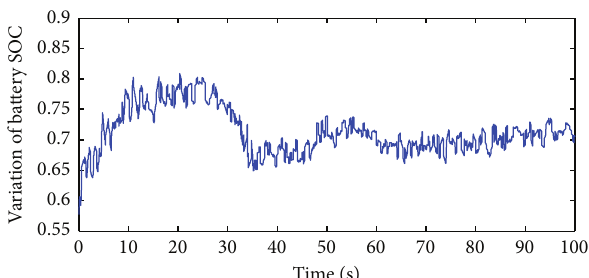
Figure 12: The variation of SOC of the lithium ion battery.